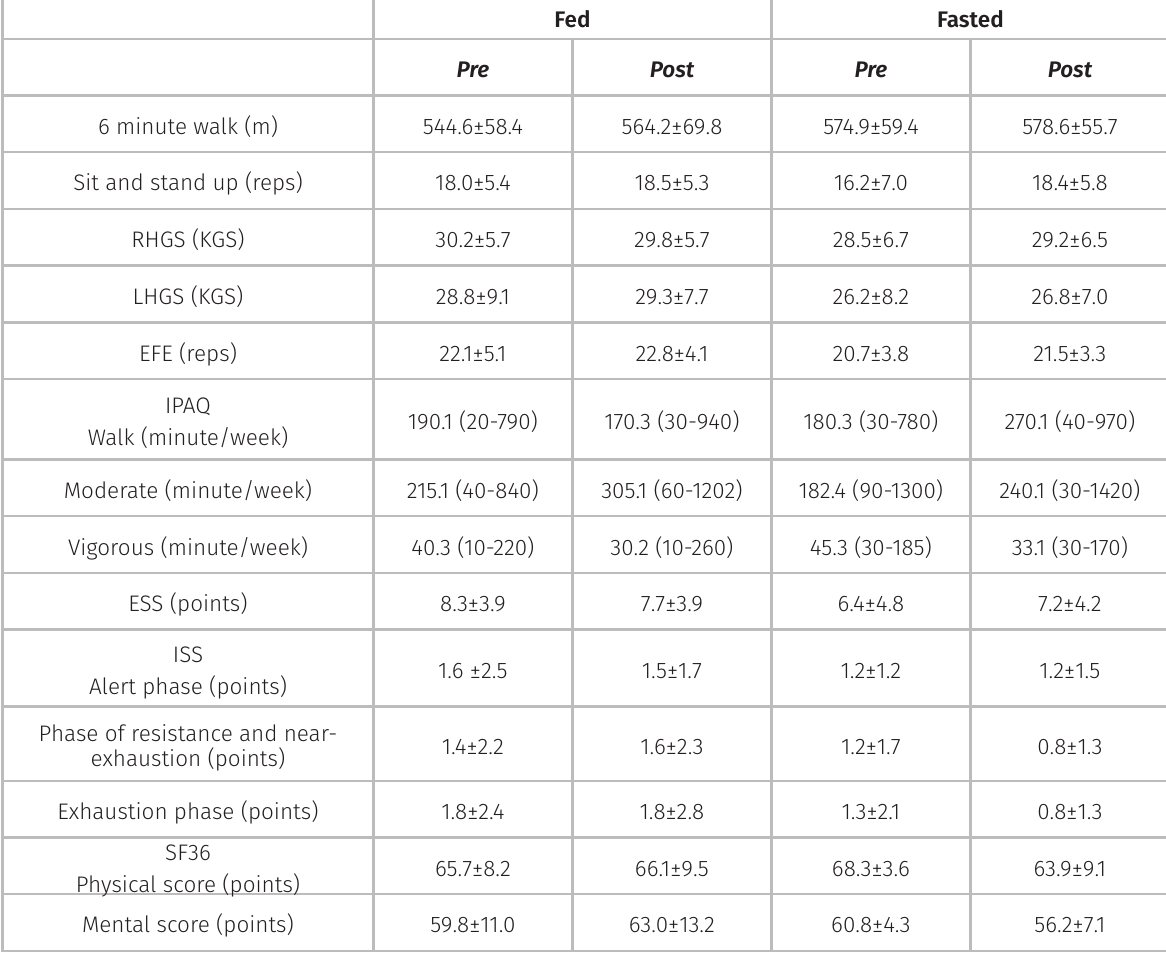
Table II. Characteristics of physical abilities and participant questionnaires between the fed and fasted conditions before and after the multicomponent training